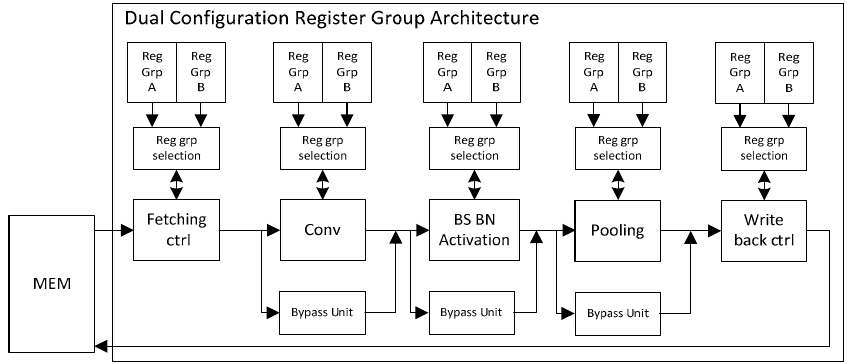
Figure 4. Dual configuration register group structure diagram.